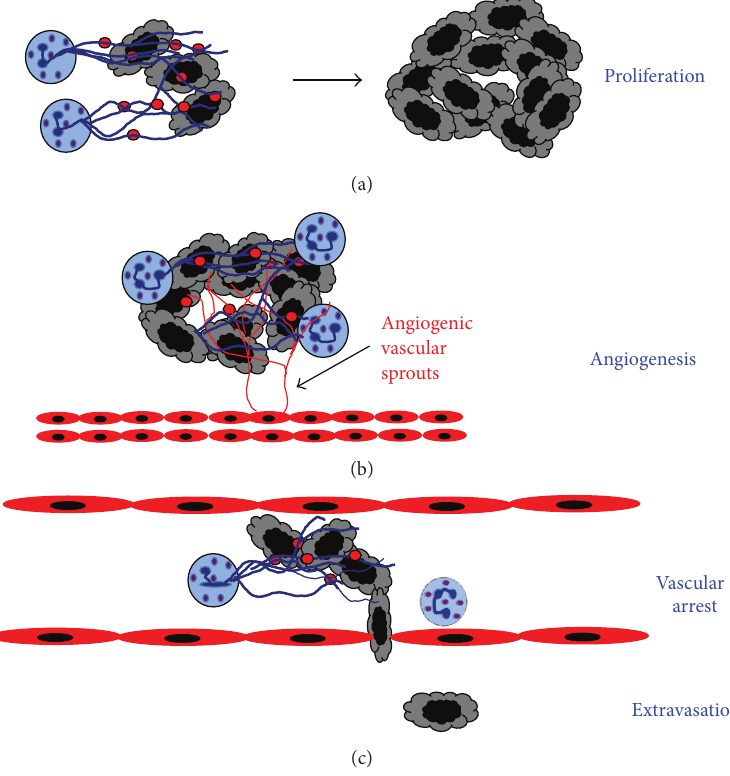
Figure 5: Neutrophil extracellular traps (NETs) can induce tumor progression. Tumor-associated neutrophils can produce NETs (blue lines), which are chromatin fibers decorated with proteins from neutrophil granules (red circles). (a) Tumor cells trapped in these NETs would get exposed to high local concentrations of neutrophil elastase and other factors that induce cell proliferation. (b) NETs could also provide large amounts of matrix metalloproteinase-9 and serine proteases that would release vascular endothelial growth factor to promote angiogenesis. (c) NETs released on the vascular endothelium in response to inflammation could trap tumor cells allowing them to more easily arrest and extravasate the blood circulation into prometastatic